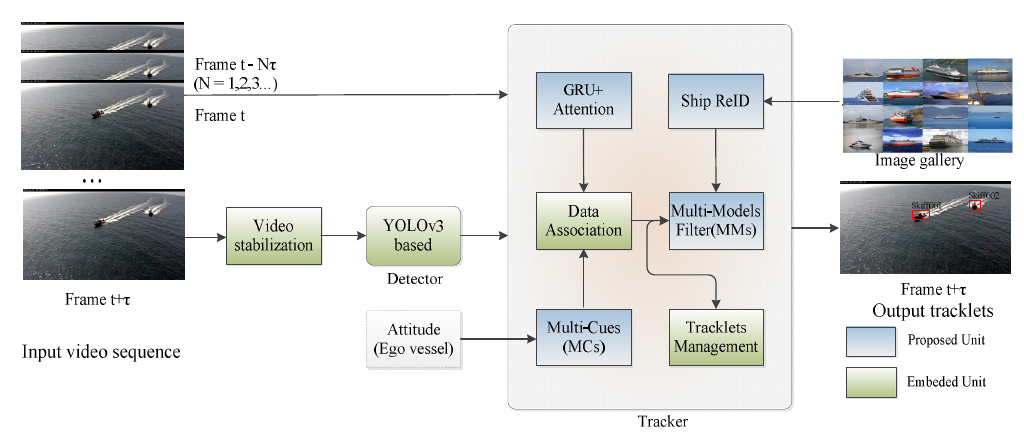
Figure 1. The architecture of our proposed M 3 C tracking by detection pipeline. It comprises eight modules, among which the video stabilization unit uses the algorithm introduced by [33]. We proposed the four blue units, and their interaction with the other three green units is discussed in detail later.